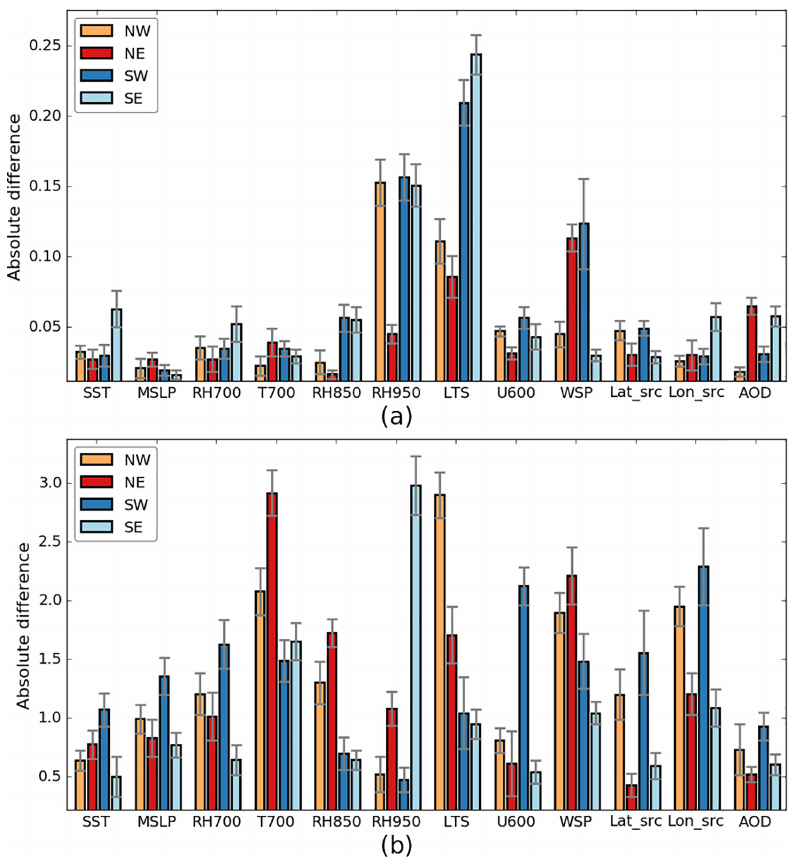
Figure 2. Mean absolute difference of maximum and minimum partial dependence of CF (a) and REF (b) on the predictors in the four subregions (colors) during JAS. “Error” bars show the minimum and maximum absolute difference of partial dependencies of all model